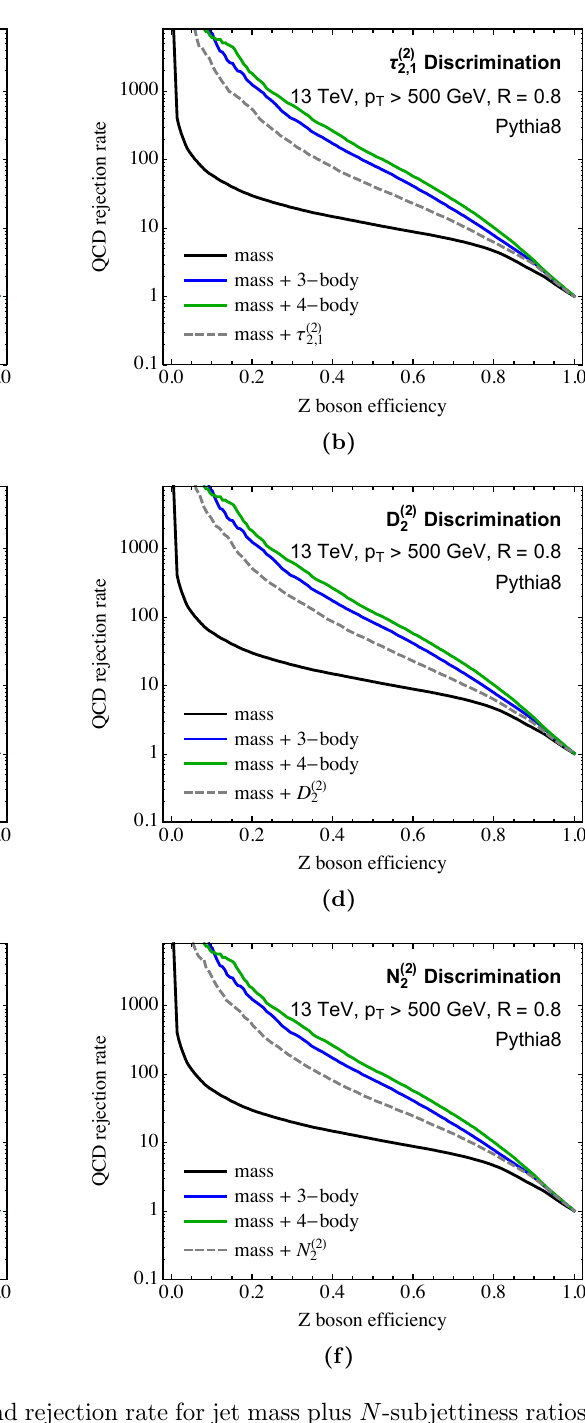
(left) and D (2) (right), and N (1) 2 2 2